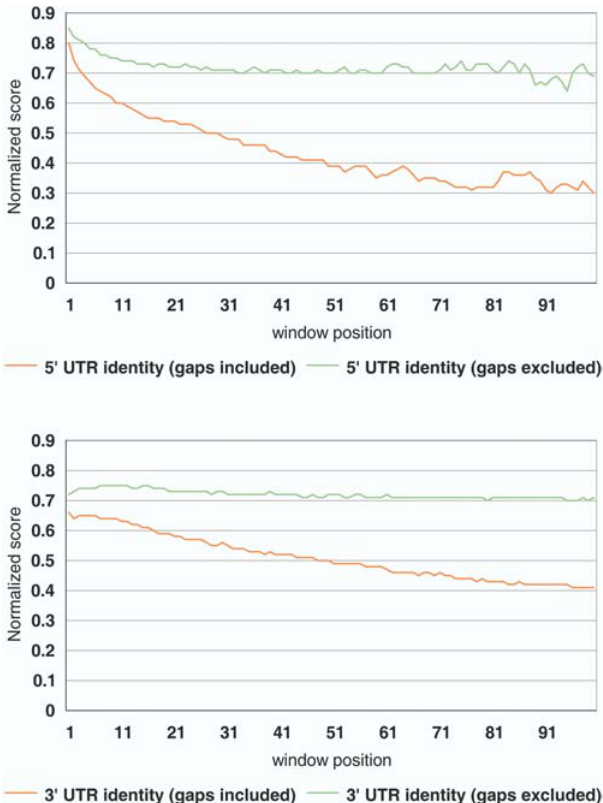
Figure 7. Window Analysis of Similarity between Human and Mouse UTRs Results for 5 9 UTRs presented above and for 3 9 UTRs below. The whole mRNA sequences were aligned using a semiglobal algorithm as implemented in the map program (Huang 1994) with the following parameters: match 10, mismatch (cid:1) 3, gap opening penalty (cid:1) 50, gap extension penalty (cid:1) 5, and longest penalized gap 10; the terminal gaps are not penalized at all. A window size of 20 bp was used with a step of 10 bp. The analysis window was moved upstream and downstream of start and stop codons, respectively. The normalized score for a given window is calculated as a fraction of an average score for all UTRs in a given window over the maximum score observed in all 5 9 or 3 9 UTRs, respectively. DOI: